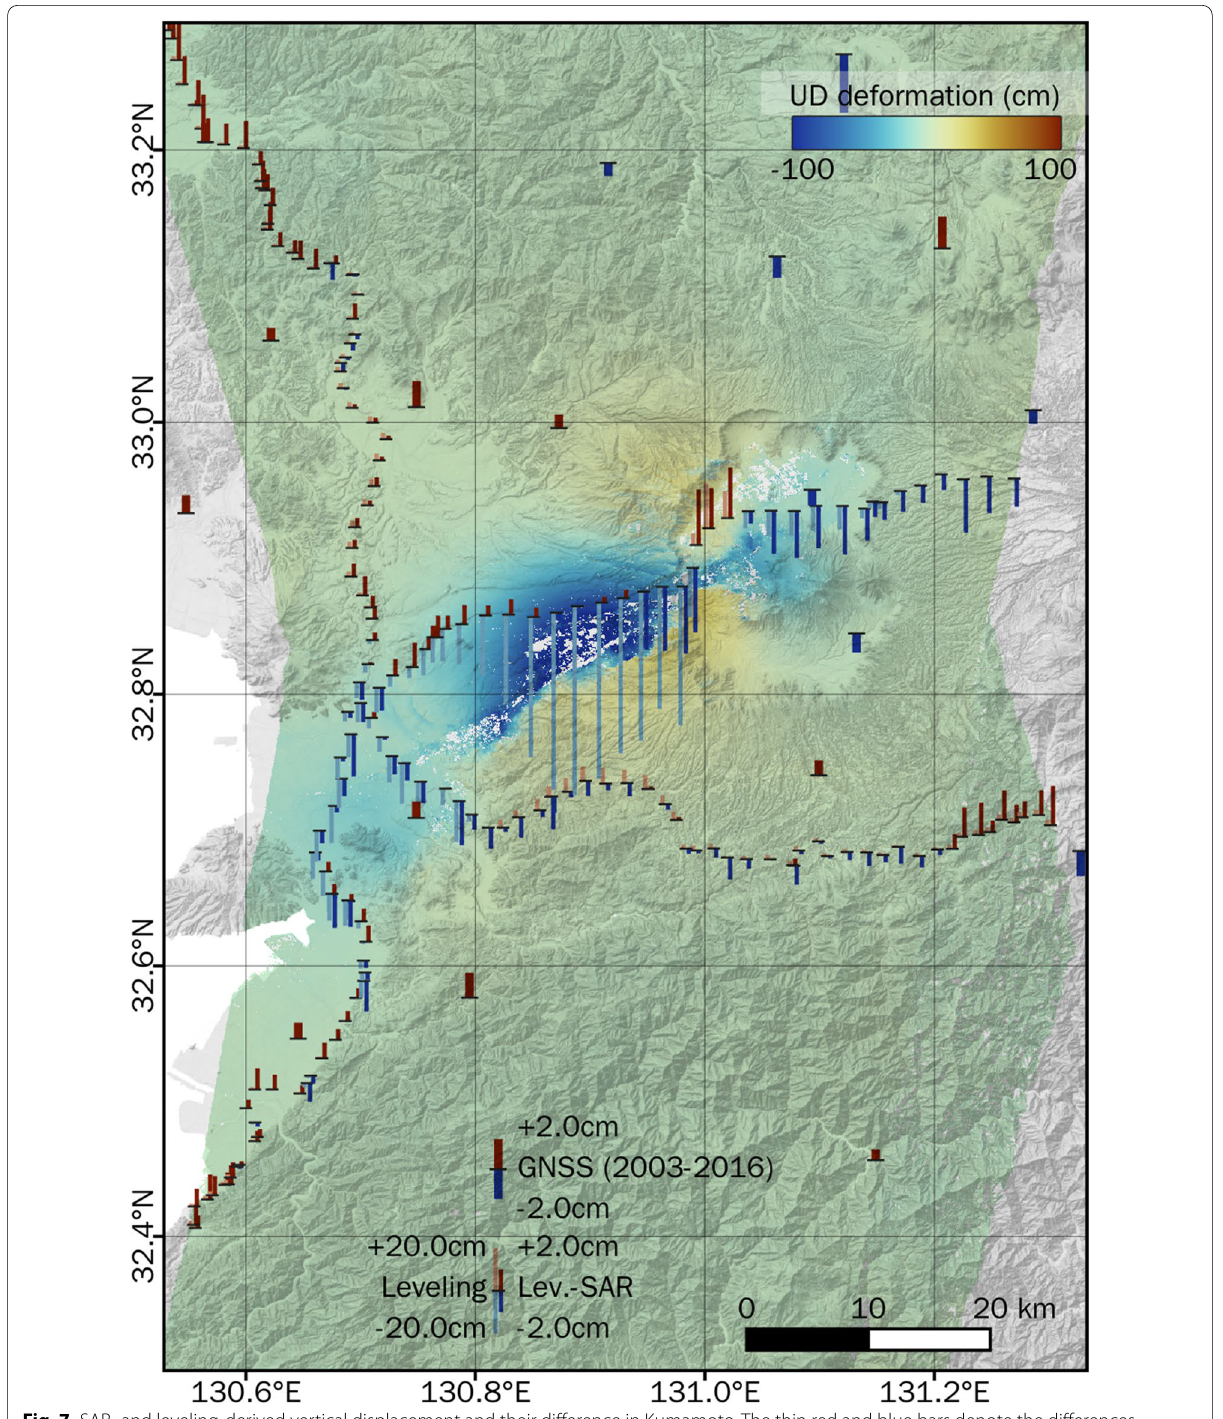
Fig. 7 SAR- and leveling-derived vertical displacement and their difference in Kumamoto. The thin red and blue bars denote the differences between SAR and leveling, while the adjacent semi-transparent bars denote the vertical displacement of the leveling itself. Note that the scale of these bars is different by a factor of five. Thick bars denote the vertical displacement at the GNSS CORS between 2003 and 2016 (i.e., before the 2016 earthquake